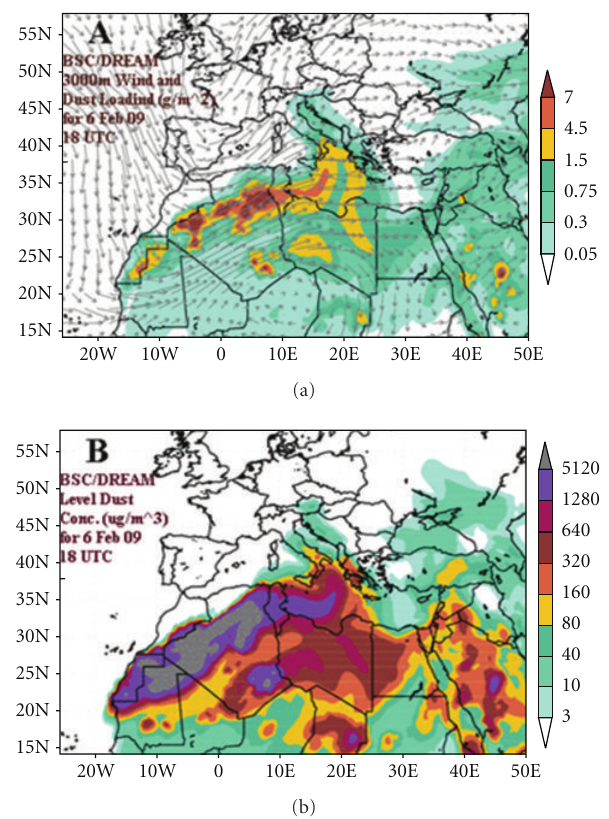
Figure 5: Same as in Figure 4, but for 6 February 2009 for 18:00